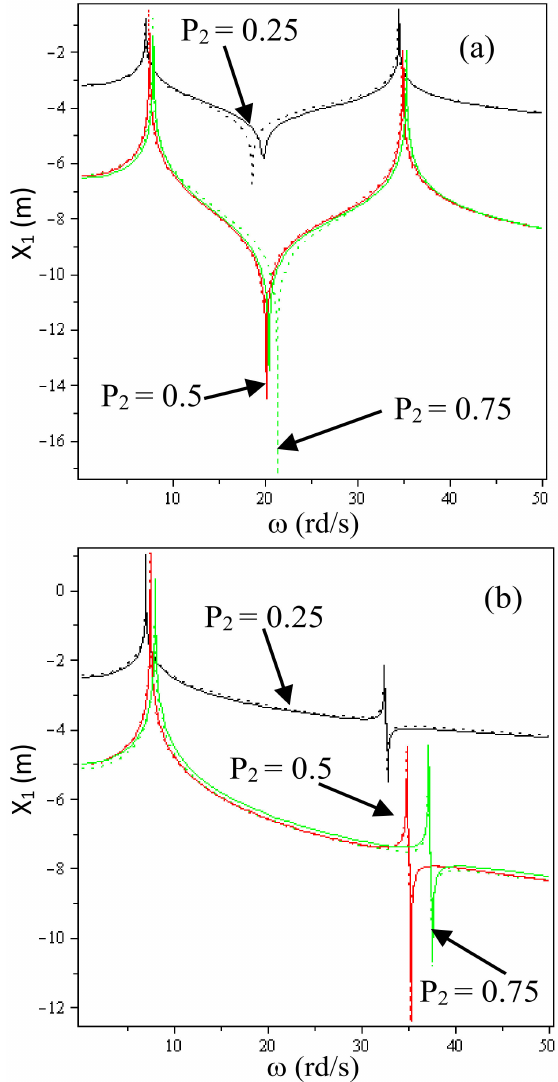
Figure 18. ( a ). Displacement x 1 versus the circular natural frequency ω . Superposition of the solution by the RPM approach (____) and the exact solution (—-). ( b ). Displacement x 1 versus the circular natural frequency ω . Superposition of the solution by the RPM approach (____) and the exact solution